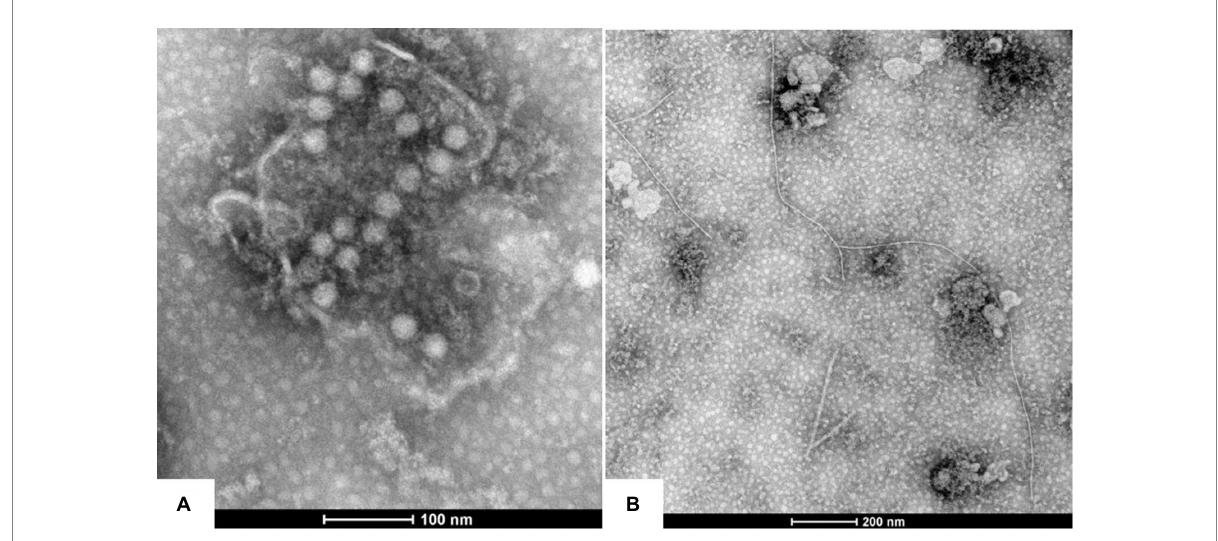
FIGURE. 2 Virions morphology associated with the virus diseases of P. yunnanensis : (A) spherical virion with a diameter of about 25 nm, (B) filamentous particles of 700 ~ 800 nm in